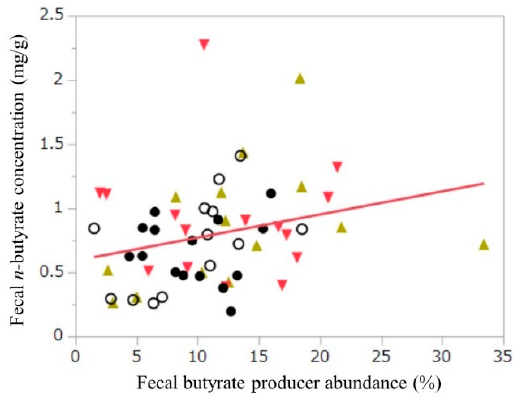
Figure 5. Relationship between the abundance of butyrate producers and the fecal concentration of butyrate at week 4. r = 0.32 (Spearman’s rank correlation coefficient), p < 0.05. ● WB − BM − , ○ WB − BM+, ▲ WB+BM − , ▼ WB+BM+.